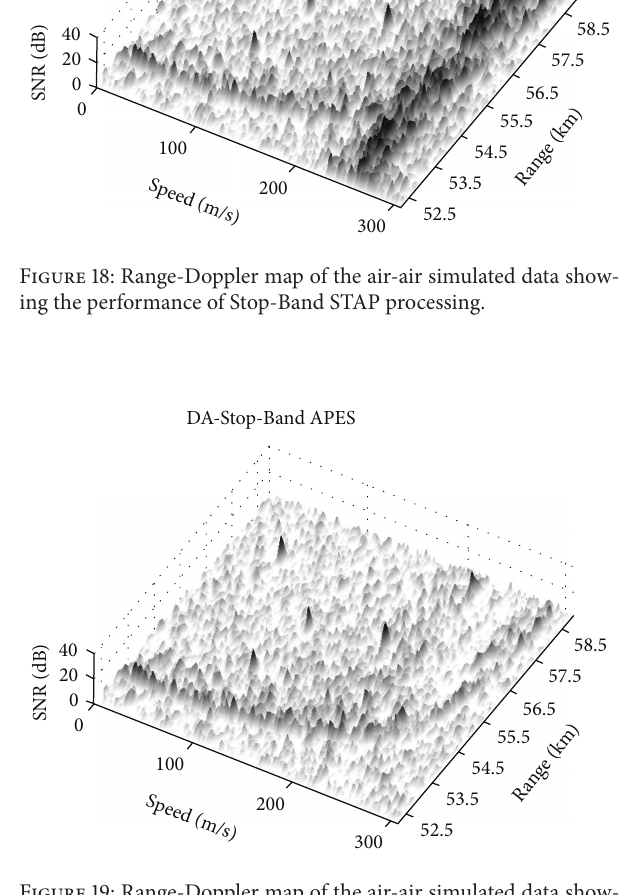
Figure 19: Range-Doppler map of the air-air simulated data show- ing the performance of deterministic aided Stop-Band STAP pro- cessing.